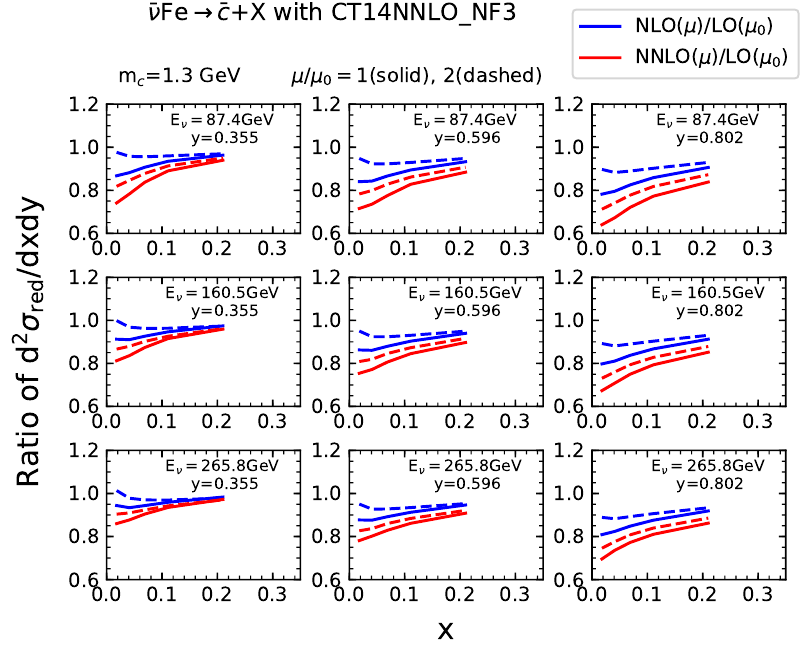
Figure 5 . Similar as (cid:12)gure 4 for charm anti-quark production from anti-neutrino scattering.